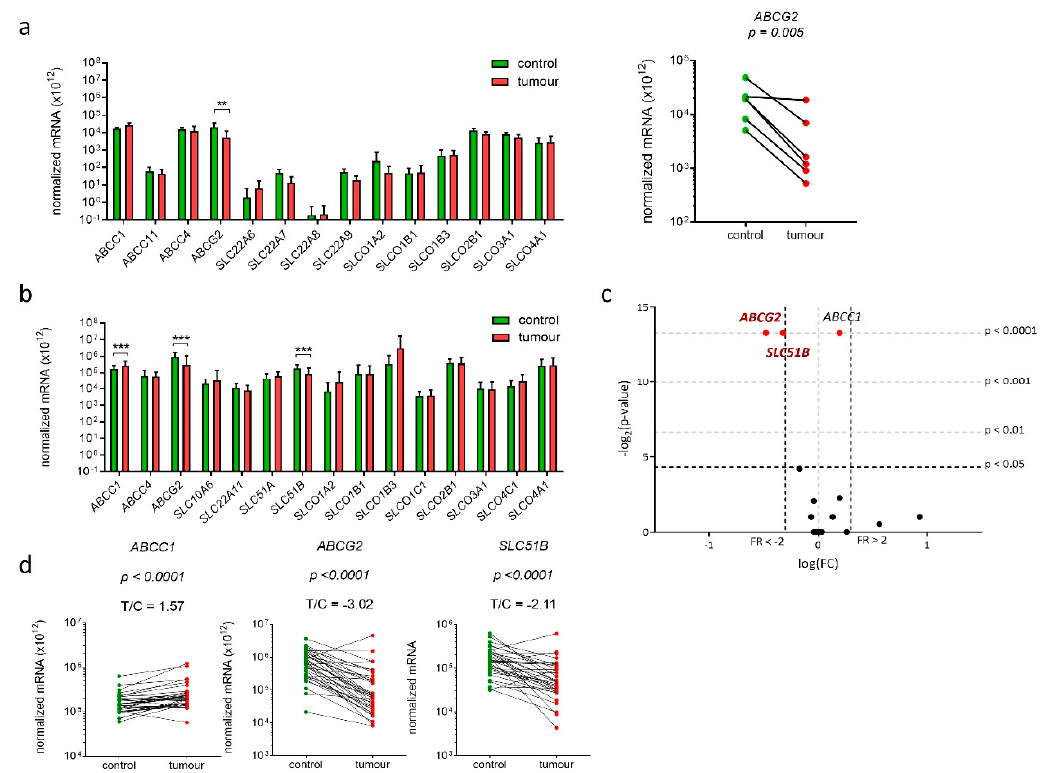
Figure 4. Expression of genes encoding E1-S transporters in 36 paired samples of EC and adjacent control tissue. ( a ) Normalized mRNA expression level of 14 genes encoding E1-S transporters (Human Drug transporters PCR Array PAHS-070Z) in 6 paired tissue samples (Wilcoxon matched pairs with Bonferroni’s multiple comparison). ( b ) Normalized mRNA expression analysis of 15 genes encoding E1-S transporters in 36 paired tissue samples (Wilcoxon matched pairs with Bonferroni’s multiple comparison tests) in EC compared to control tissue. ( c ) Volcano plot shows the most significantly down-regulated and the most significantly up-regulated genes. ( d ) Before-and-after graphs show the normalized mRNA levels for genes ABCC1, ABCG2 and SLC51B in 36 paired tissue samples. Data are shown as a mean ± SD on the logarithmic scale. ** p -value ≤ 0.01, *** p -value ≤ 0.001.